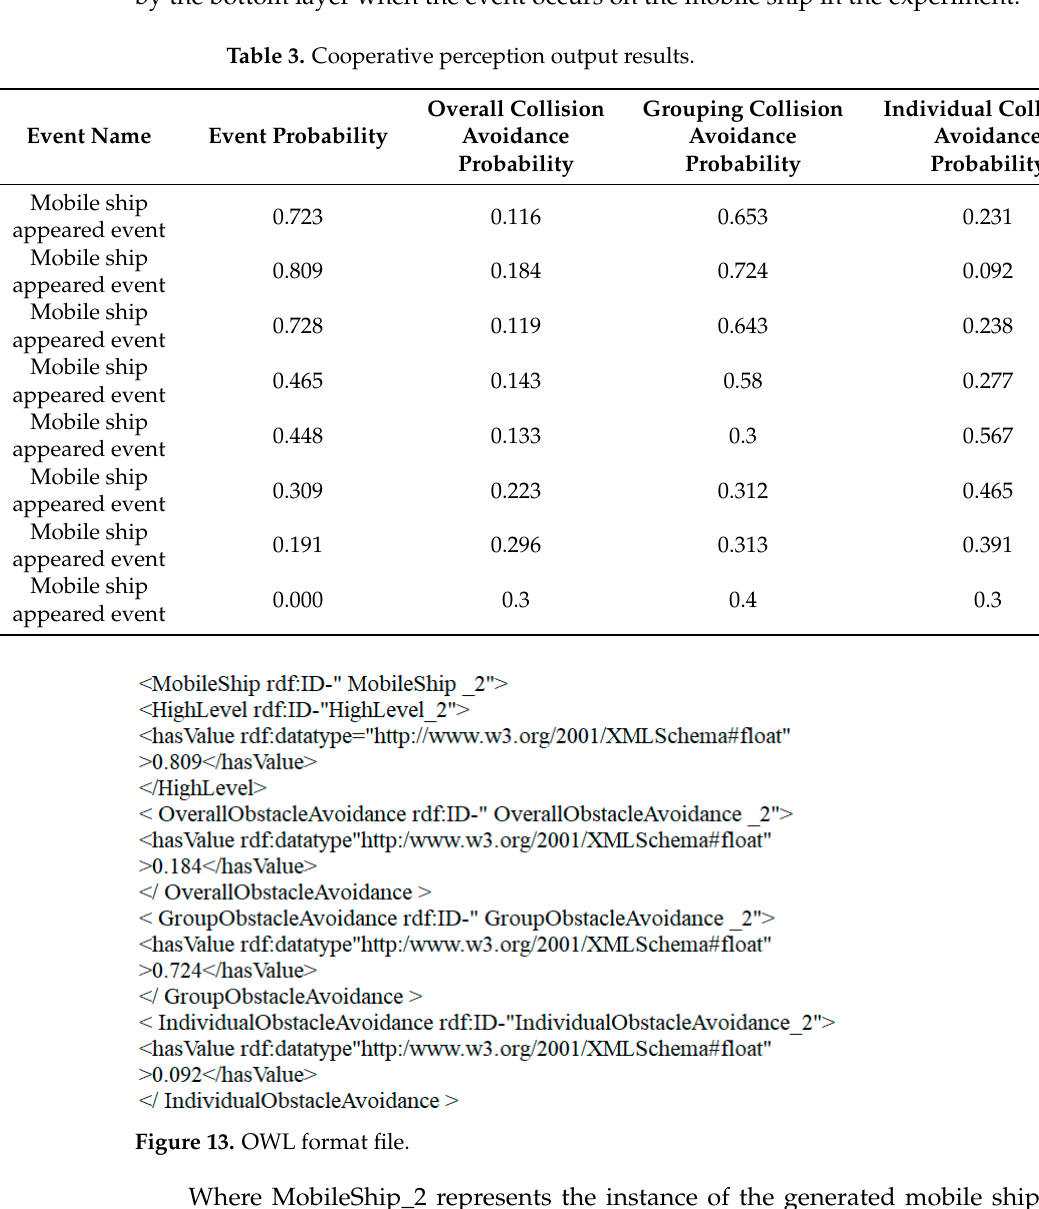
Table 4. Synergistic perception output results.